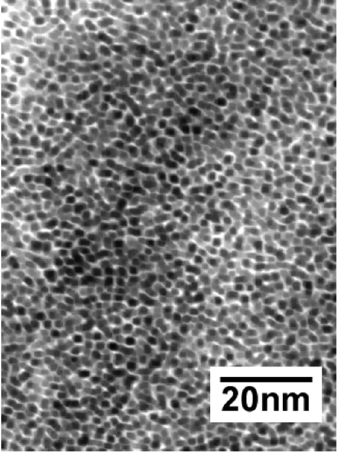
Figure 10. TEM micrograph of a self-assembly thin film of PPh 3 -Pt nanoclusters. Reproduced with permission, Copyright 2002 from American Chemical Society [28] .